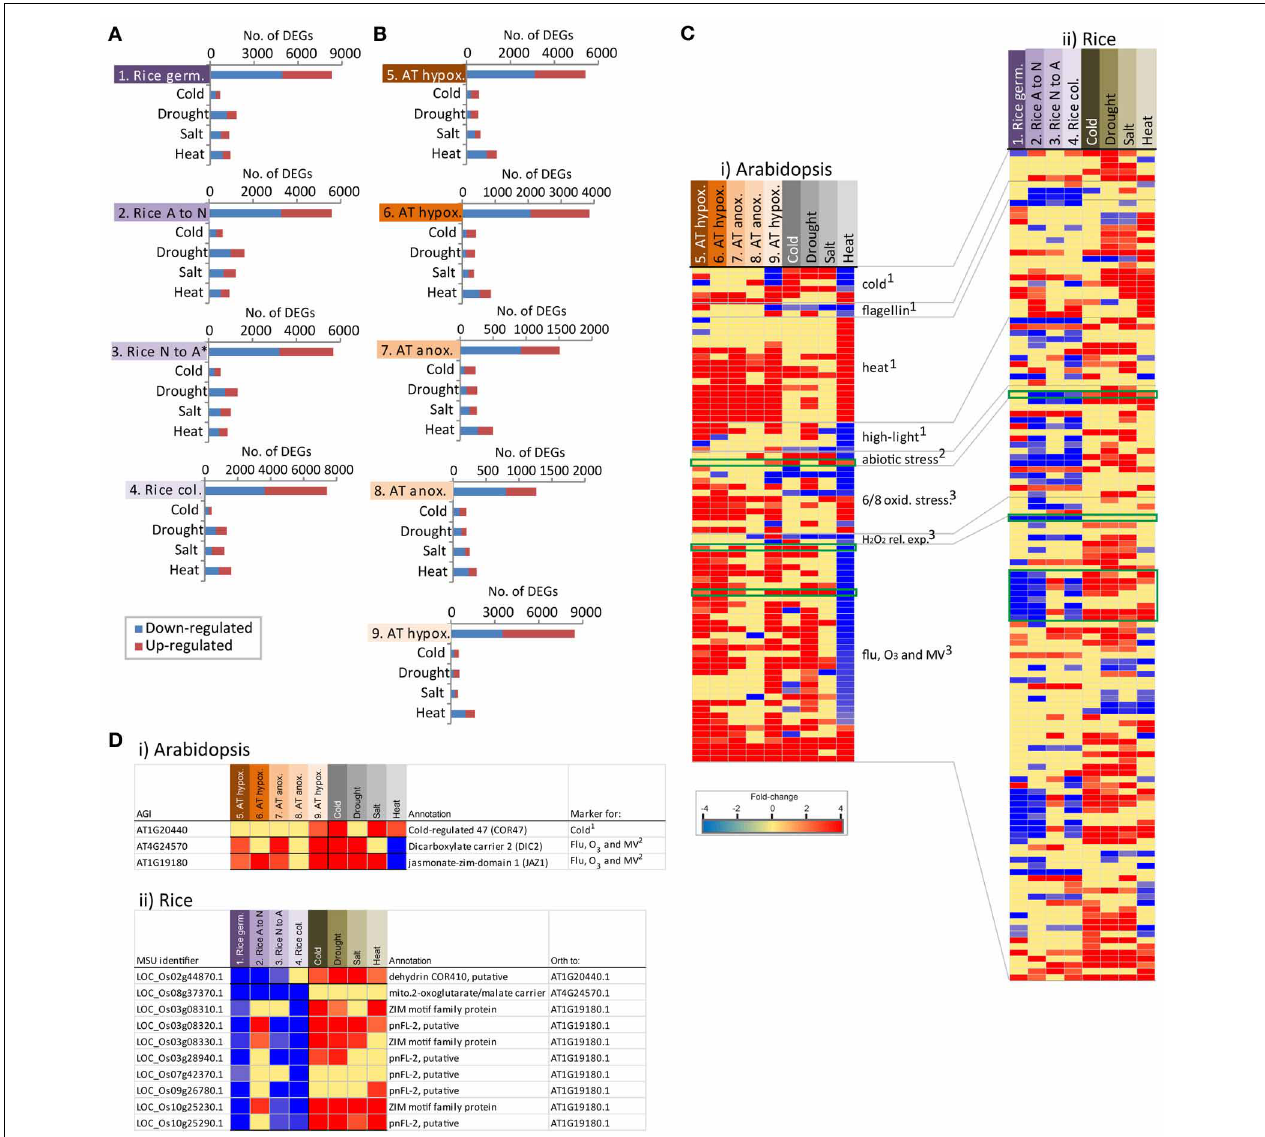
FIGURE 4 | Overlapping responses between low oxygen and abiotic stress in rice and Arabidopsis. (A) Differentially expressed genes from each of the four low oxygen transcriptome datasets in rice (Lasanthi-Kudahettige et al., 2007; Narsai et al., 2009) were overlapped with the differentially expressed genes in response to cold, drought, salt, and heat stress (Jain et al., 2007; Hu et al., 2009). The numbers of genes showing overlapping responses are shown. The ∗ indicates that the fold-changes were inversed for this comparison to show the response to anoxia. (B) Differentially expressed genes from each of the five low oxygen transcriptome datasets in Arabidopsis (Loreti et al., 2005; Branco-Price et al., 2008; Christianson et al., 2009, 2010; Banti et al., 2010) were overlapped with the differentially expressed genes in response to cold, drought, salt, and heat stress (Kilian et al., 2007). The